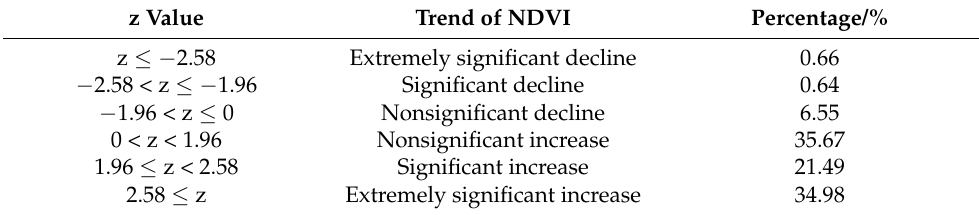
Figure 5. The variation trends ( a ) and significances ( b ) of the NDVI in the Qaidam Basin 2001–2016. Table 1. Statistics of the NDVI variation trend in the Qaidam